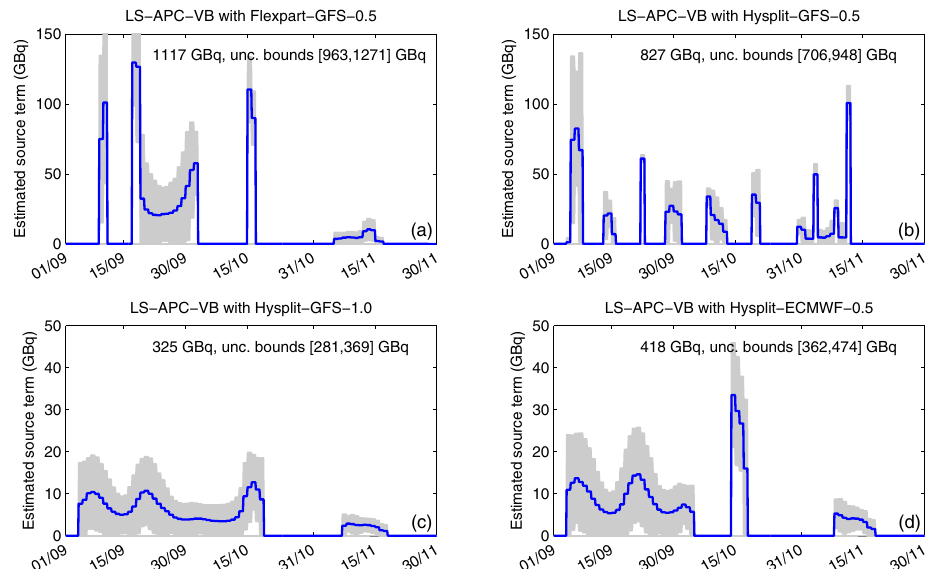
Figure 3. Estimated source terms at locations selected by the marginal likelihood method, shown in Fig. 2, using the LS-APC-VB algorithm for all four tested combinations of dispersion models and meteorological data: Flexpart-GFS-0.5 (a) , Hysplit-GFS-0.5 (b) , Hysplit-GFS-1.0 (c) , and Hysplit-ECMWF-0.5 (d) . The estimated source terms are accompanied by the 95% uncertainty regions (gray filled regions). The estimated activity for the whole period is reported inside each plot with its associated uncertainty bounds.